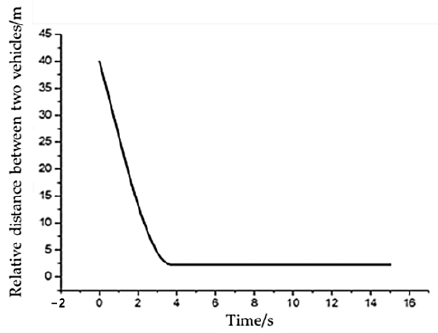
Figure 8. Relative distance between two vehicles in CCRs test.